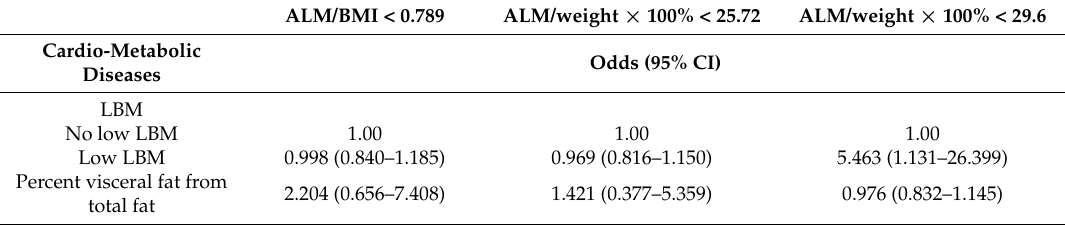
Table 5. Odds of cardiometabolic diseases with reduced LBM among participants with overweight and